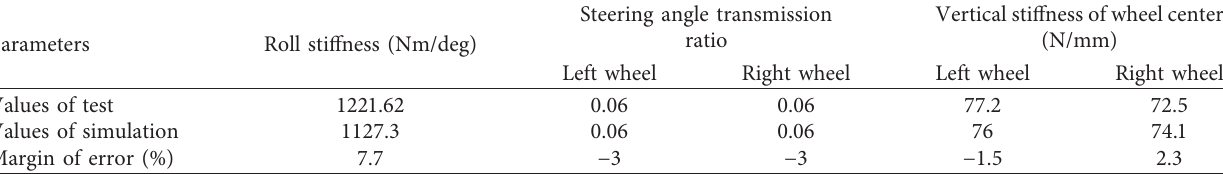
Table 4: K&C characteristics of suspension-comparison of the experimental and numerical analysis results.